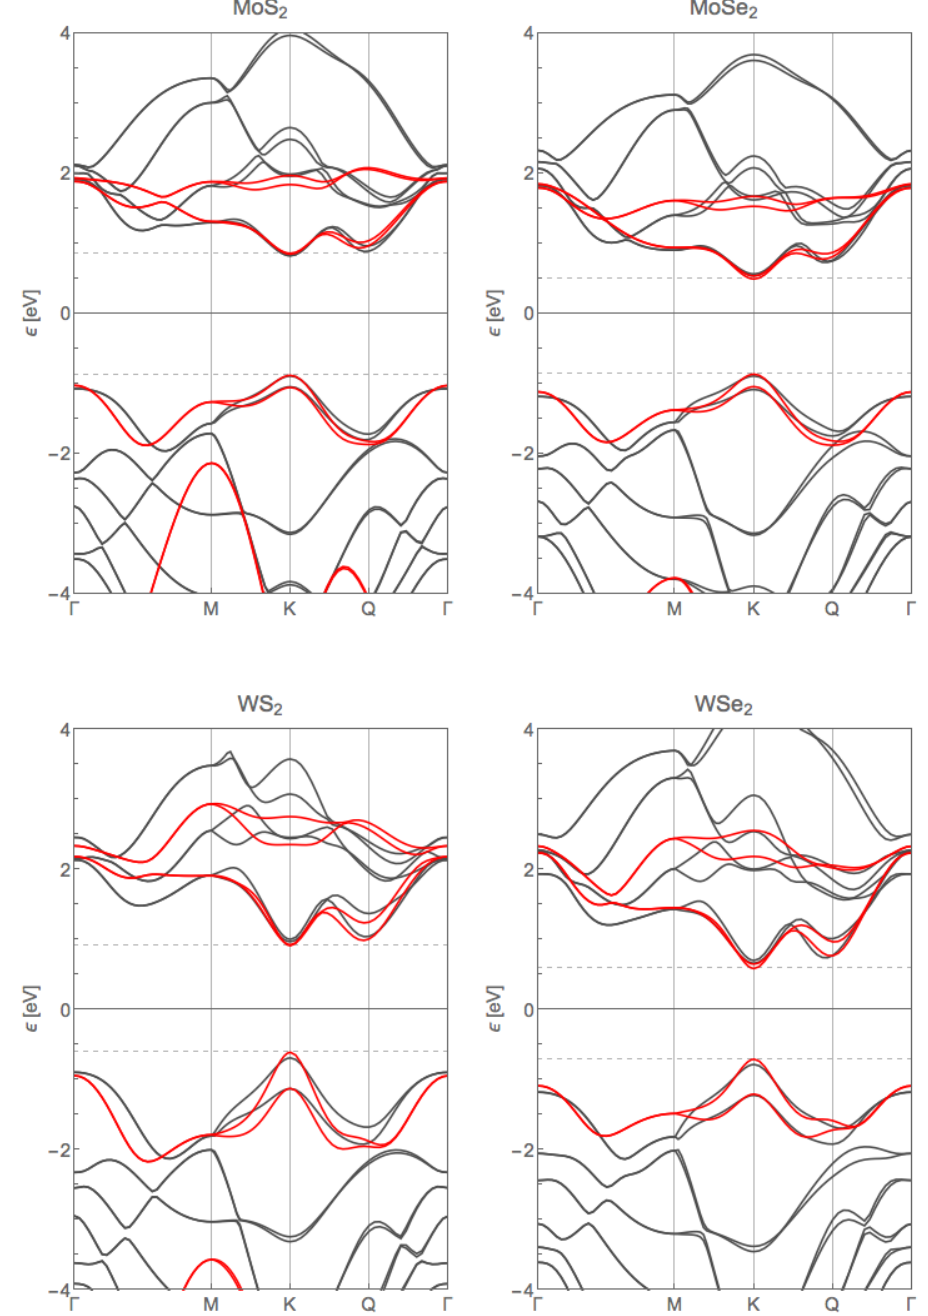
Figure 3. Electronic band structure of single-layer MX 2 from Density Functional Theory (DFT) calculations ( black lines) and from tight-binding (TB) ( red